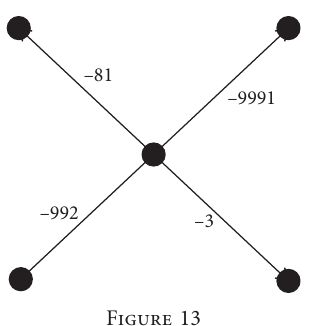
algorithm depends on star graphs. Labeled graphs are sent to the recipient. It is a best possible way to secure the